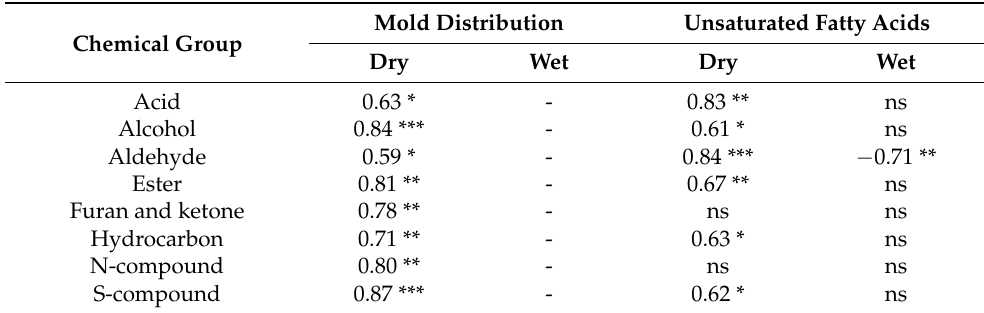
Table 8. Pearson correlation coefficient for volatile compounds in dry- and wet-aged beef with their mold distribution and unsaturated free fatty acid